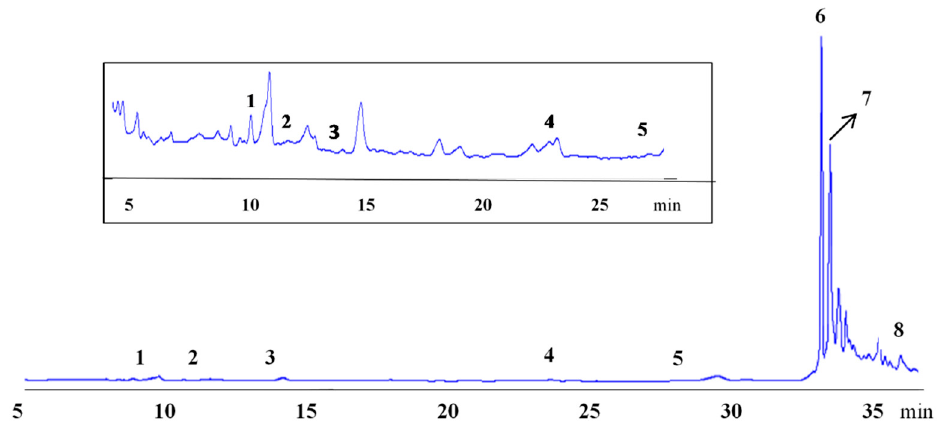
Figure 3. High performance liquid chromatography (HPLC) chromatogram of Felina hempseed phenolic extract at 280 nm. Peaks identification: 1, protocatechuic acid. 2,4-hydroxybenzoic acid. 3, vanillic acid. 4, p-coumaric acid. 5, ferulic acid. 6, N- trans -caffeoyl-tyramine. 7, cannabisin A. 8, cinnamic acid.